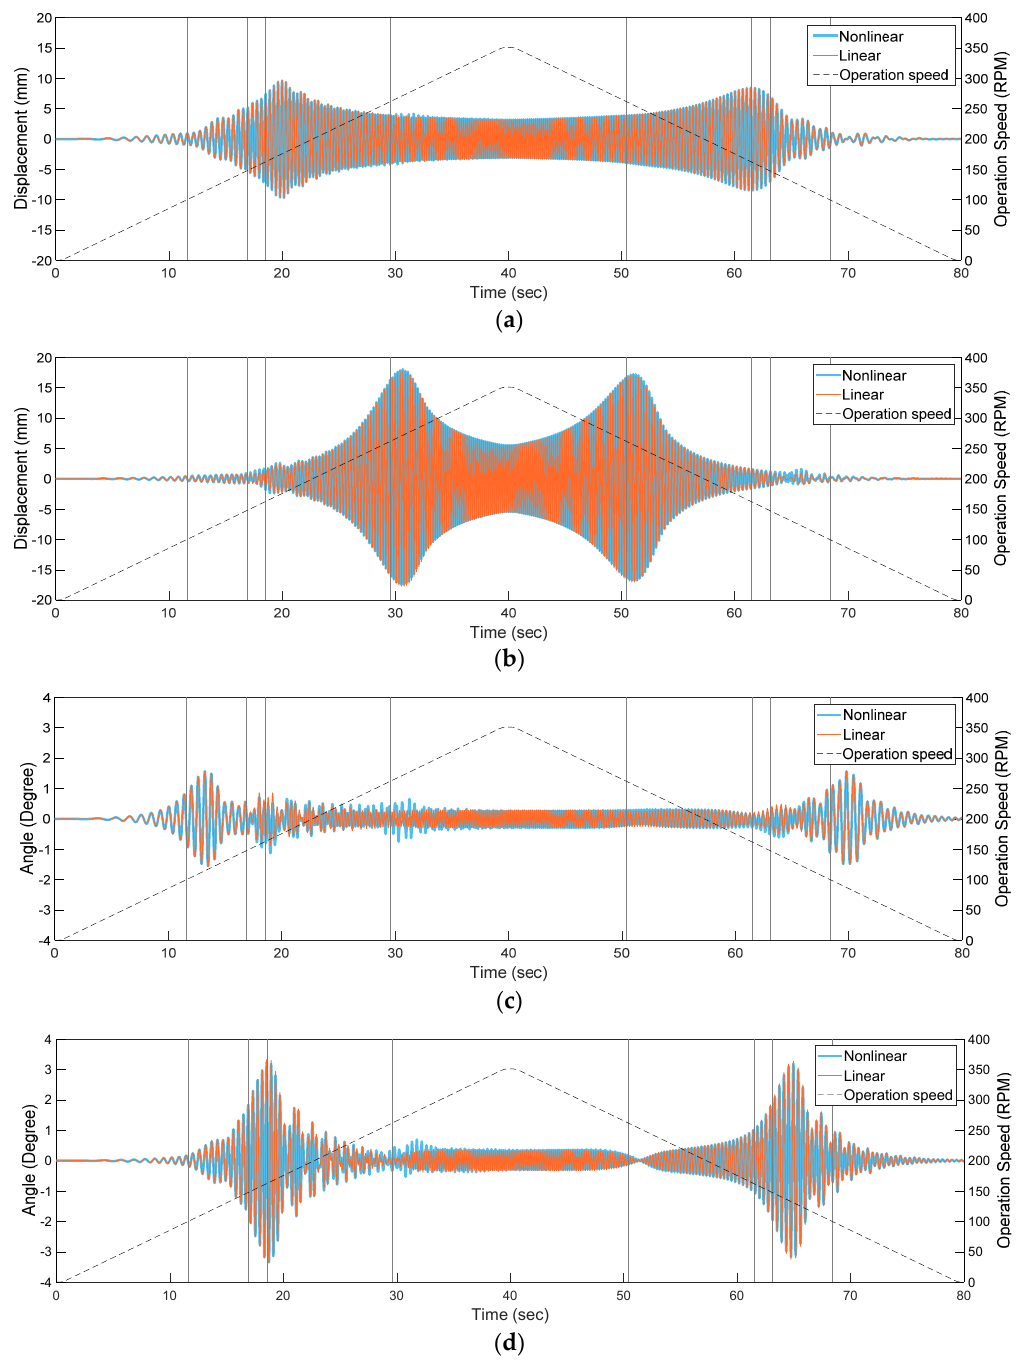
Figure 10. Comparison of transient analysis results obtained with the nonlinear and linear analytical models (when = 140 N · s/m): ( a ) horizontal displacement of the mass center, ( b ) vertical displacement of the mass center, ( c ) rocking angle in the horizontal plane, and ( d ) rocking angle in the vertical